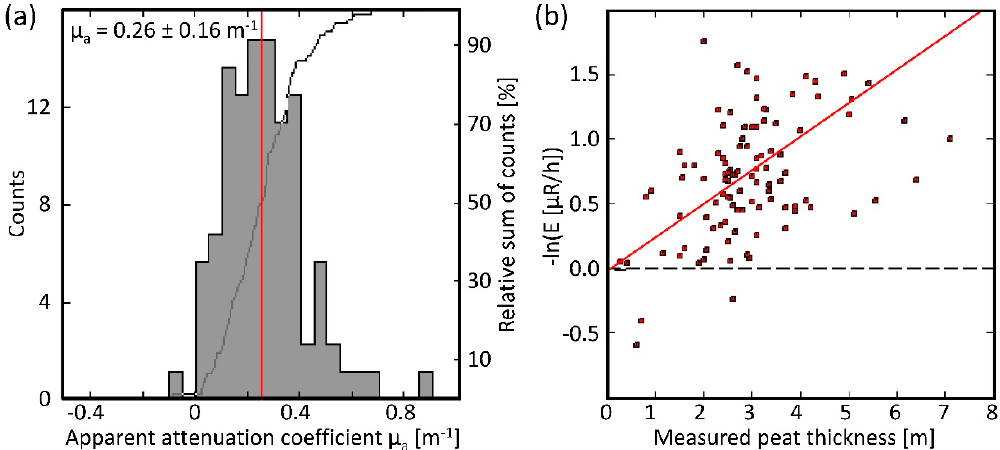
Figure 17. Estimation of the apparent attenuation coefficient (µ a ) from exposure rates (E) and peat thicknesses found in boreholes. The red lines in the histogram ( a ) and the scatter plot ( b ) indicate the mean value and the corresponding linear relationship, assuming E 0 = 1 µ R / h, respectively. The three negative values observed in the scatter plot belong to boreholes located close to the border of the bog.